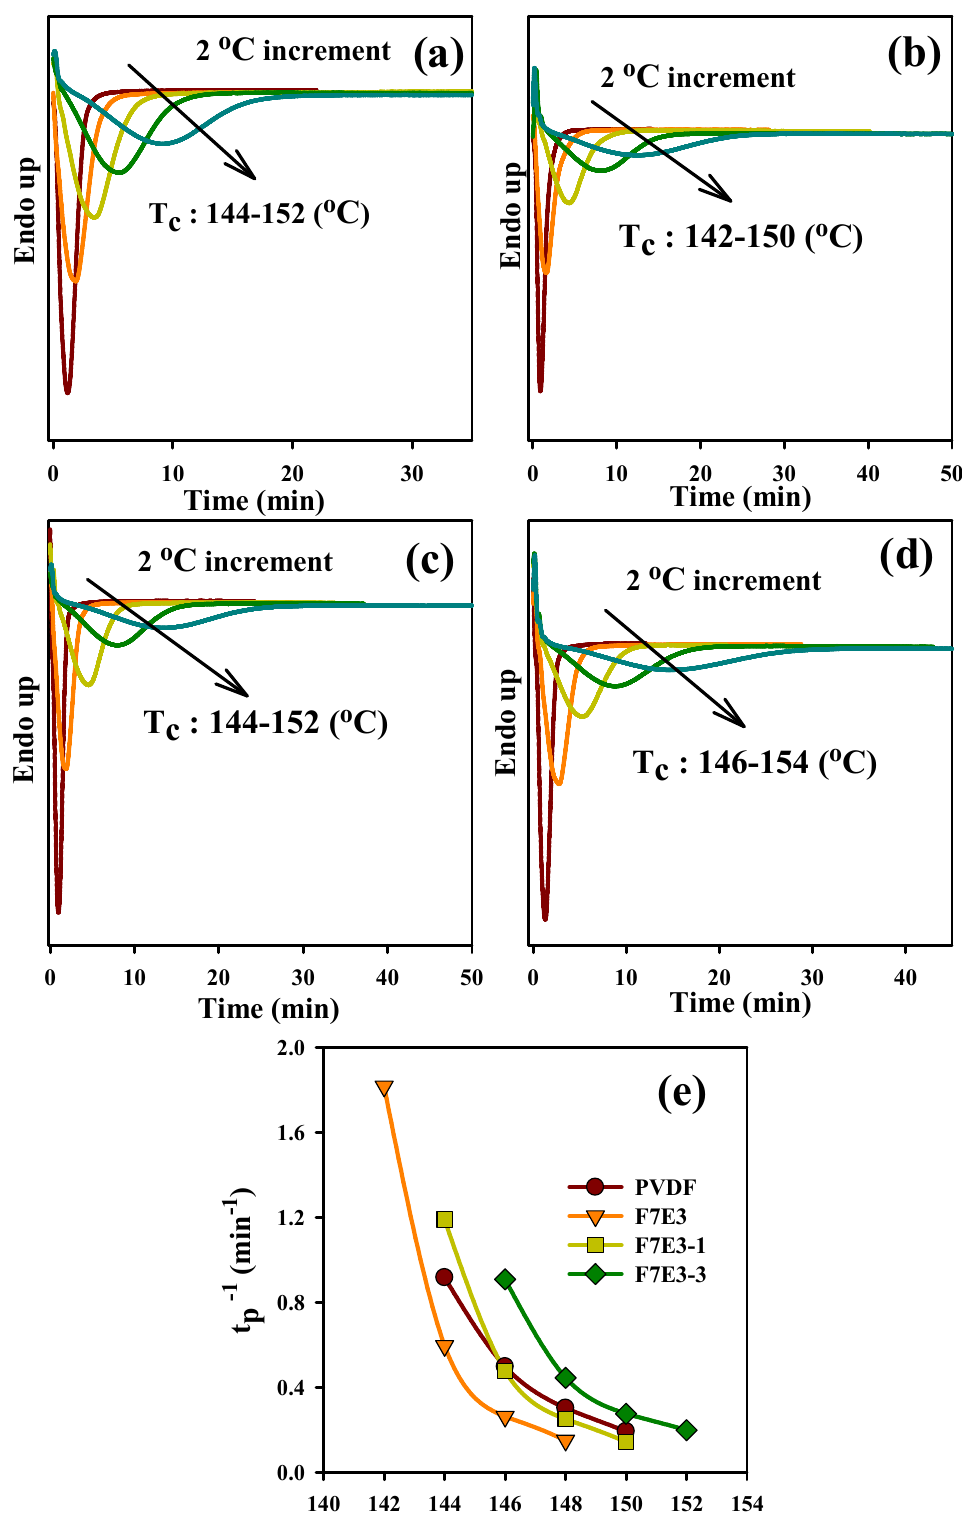
Figure 4. DSC traces of PVDF isothermally crystallized at indicated T c s in different samples: ( a ) PVDF, ( b ) F7E3, ( c ) F7E3-1, ( d ) F7E3-3, and ( e ) t p − 1 vs. T c of PVDF in representative samples.